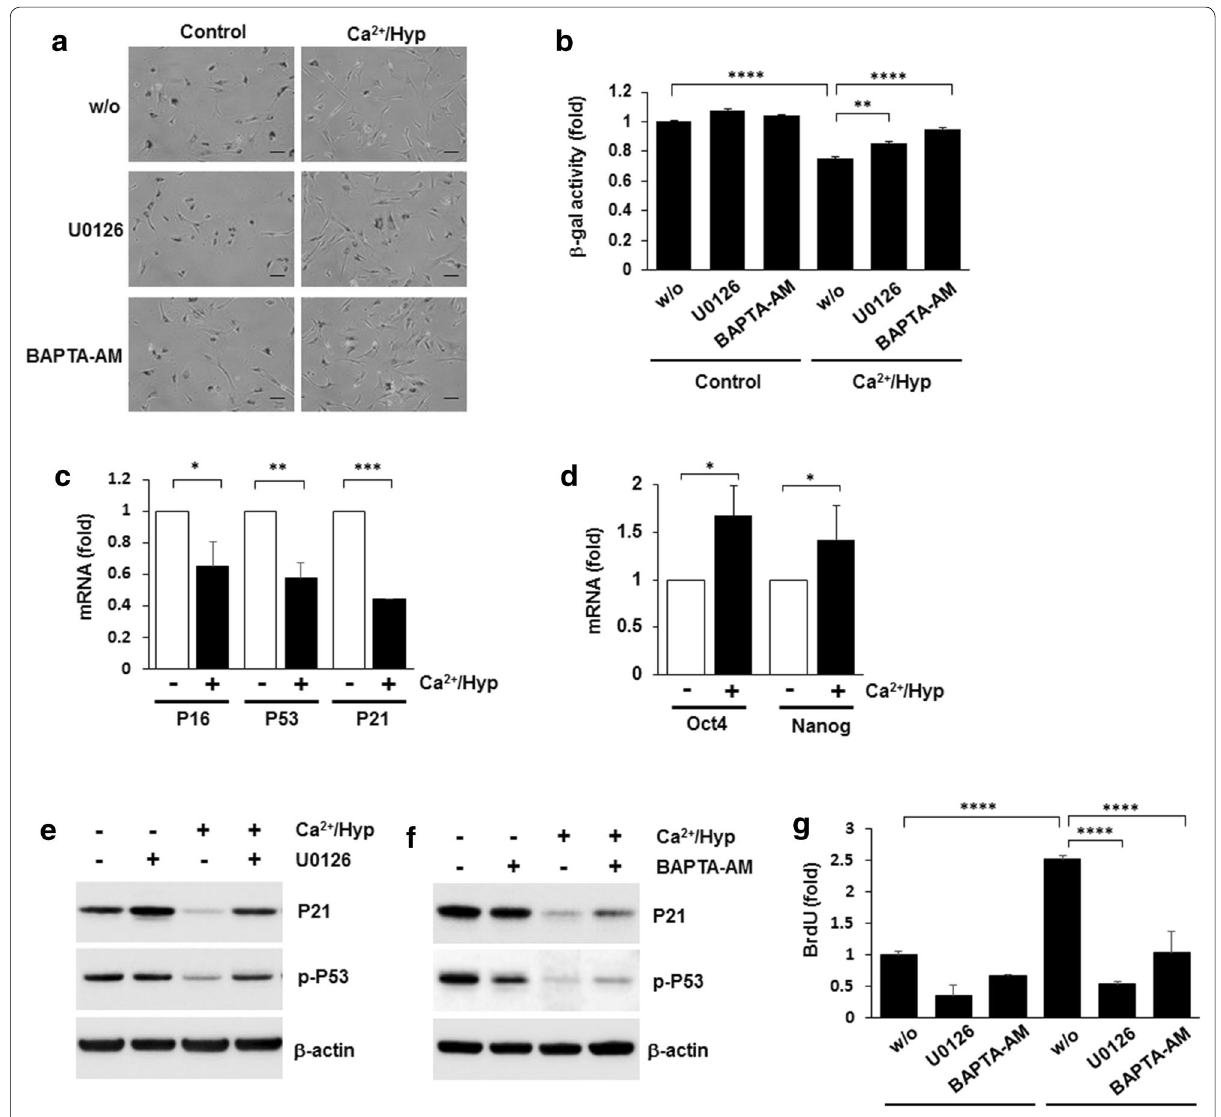
Fig. 5 Effects of Ca 2 + /hypoxia on the senescence of hUCB‑MSCs. hMSCs were treated with Ca 2 + /hypoxia for five passages in the absence or pres‑ ence of U0126 or BAPTA‑AM. a Senescence stage was determined using SA‑β‑gal activity assays. b Staining was quantified by positive cell counts. c , d The mRNA levels of senescence‑associated genes, i.e., p16, p53, and p21, or stemness marker genes, i.e., Oct4 and Nanog, were determined by real‑time PCR analysis. e , f The expression levels of senescence‑associated proteins, i.e., p21 and p‑p53, were determined by western blot analysis. g Ca 2 + /hypoxia‑induced cell proliferation was significantly decreased in the groups treated with U0126 or BAPTA‑AM. Data represent the mean n 3; # P < 0.01, * P < 0.05, ** P < 0.01, *** P < 0.001, **** P < 0.0001. Scale bar =